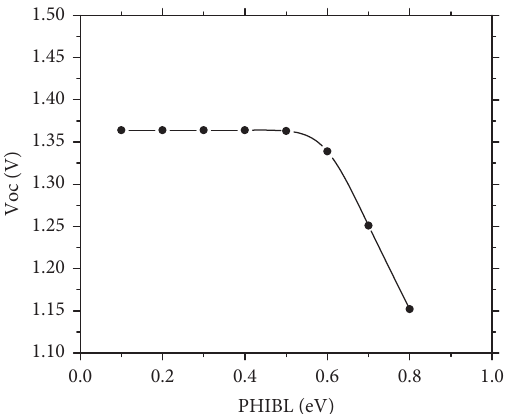
Figure 6: PHIBL versus e ffi ciency plot of the proposed solar cell ’ s back contact.